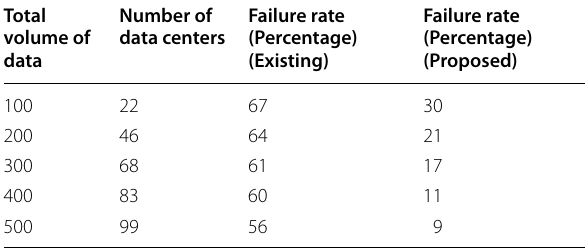
Table 4 Failure rate of data in multiple cloud Total volume